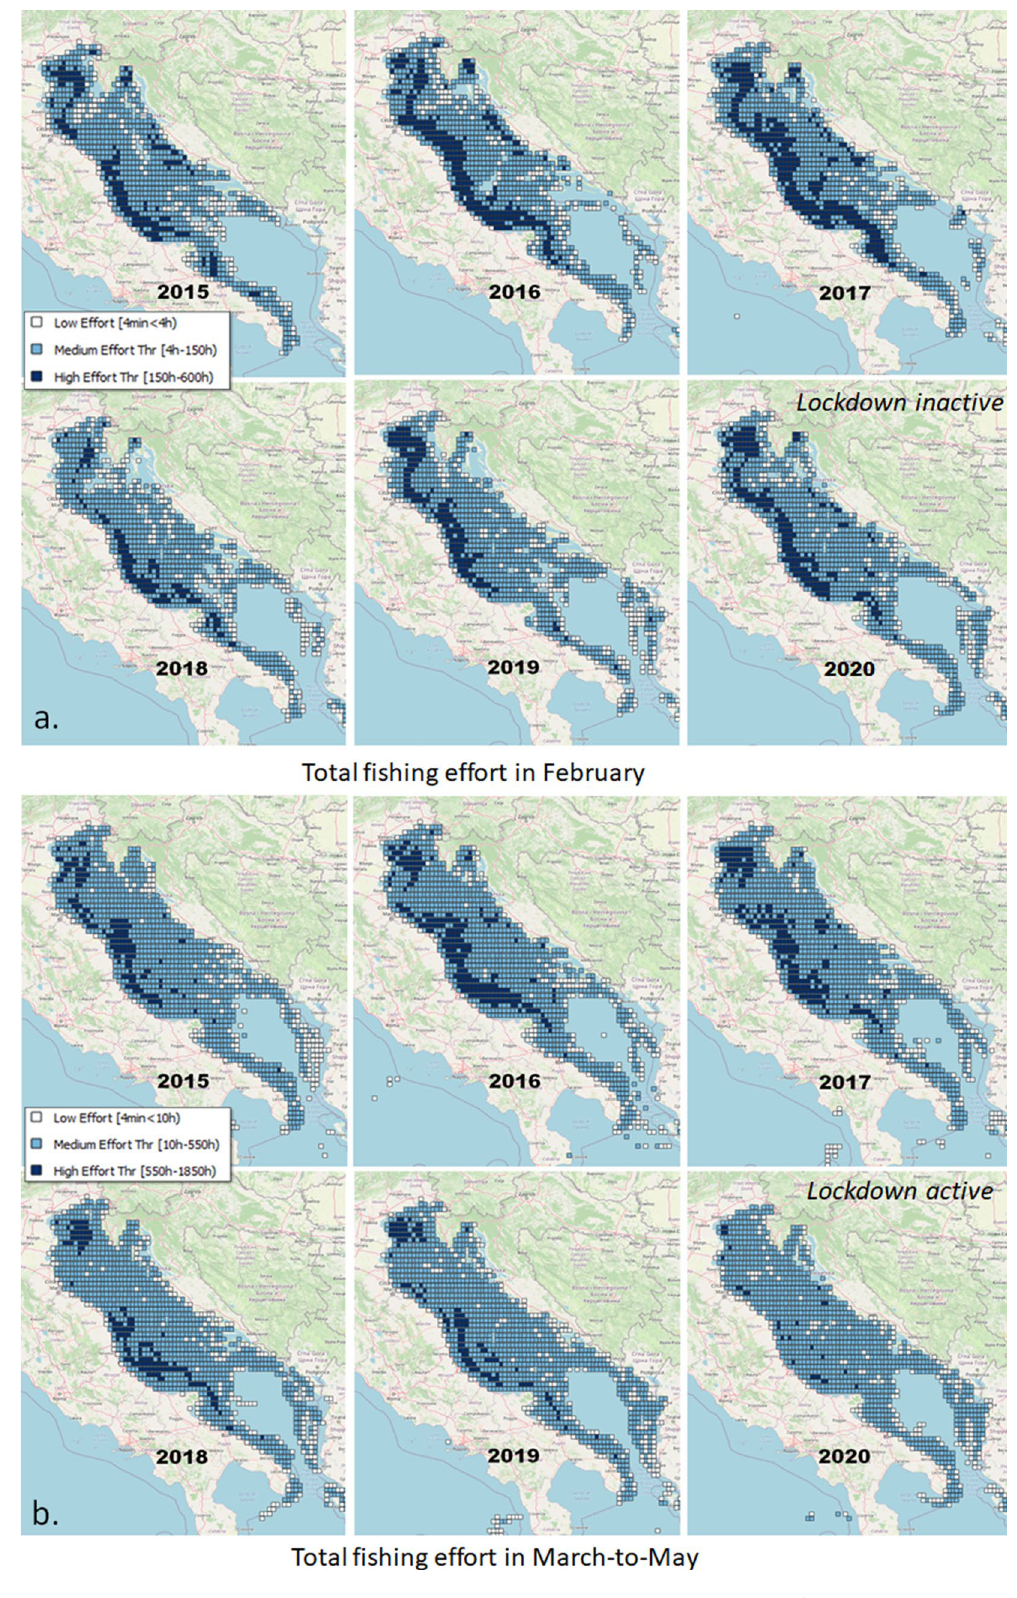
Figure 3. Comparison of the distributions of total fishing hours in the Adriatic Sea (0.1 2020 in ( a ) February and ( b ) March-to-May (aggregated). The classification of the 2015 distribution is used for all years for consistency. Maps were created with QGIS v.3.20.2 (www. qgis. org) using the OSM-Standard map of the QuickMapService plugin as the background